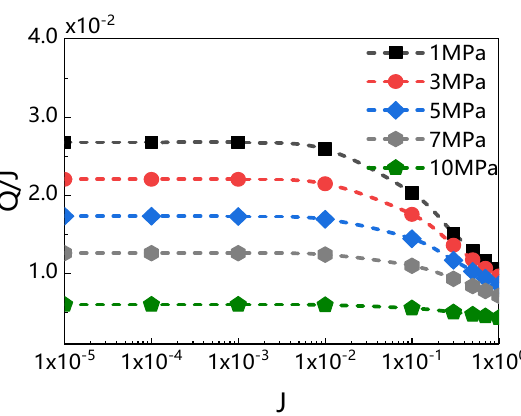
Figure 16. Relationship between Q / J and J .